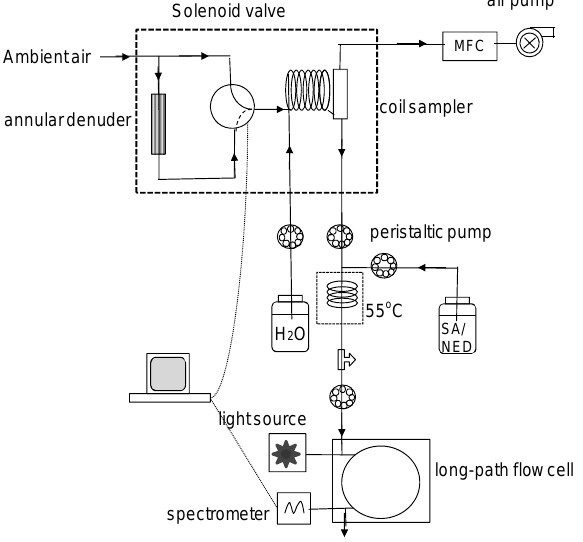
Fig. 1. A schematic diagram of a HONO measurement system.